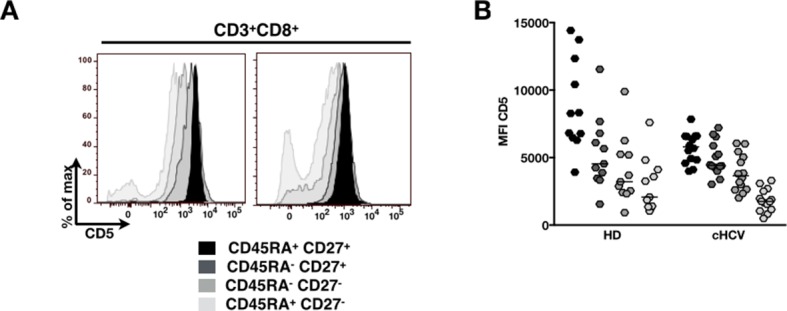
Evolution of MFI of CD5 over T cell differentiation in HD and cHCV patients.(A) Representative histograms of CD5 in CD8+ T cell differentiation subsets in one HD and one cHCV patient. (B) MFI of CD5 on CD8+ T cell differentiation subsets from HD and cHCV donors.